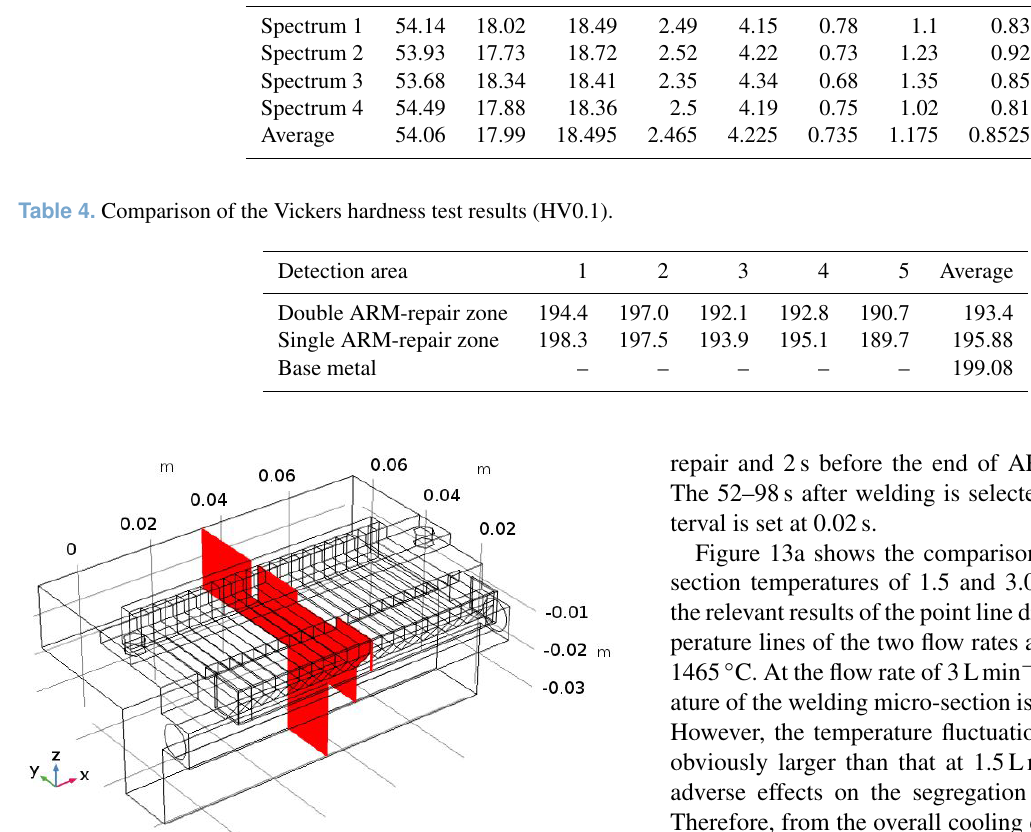
Table 3. Mass percentages of the chemical composition of the ARM-repair zone (weight percentage; wt%). Component